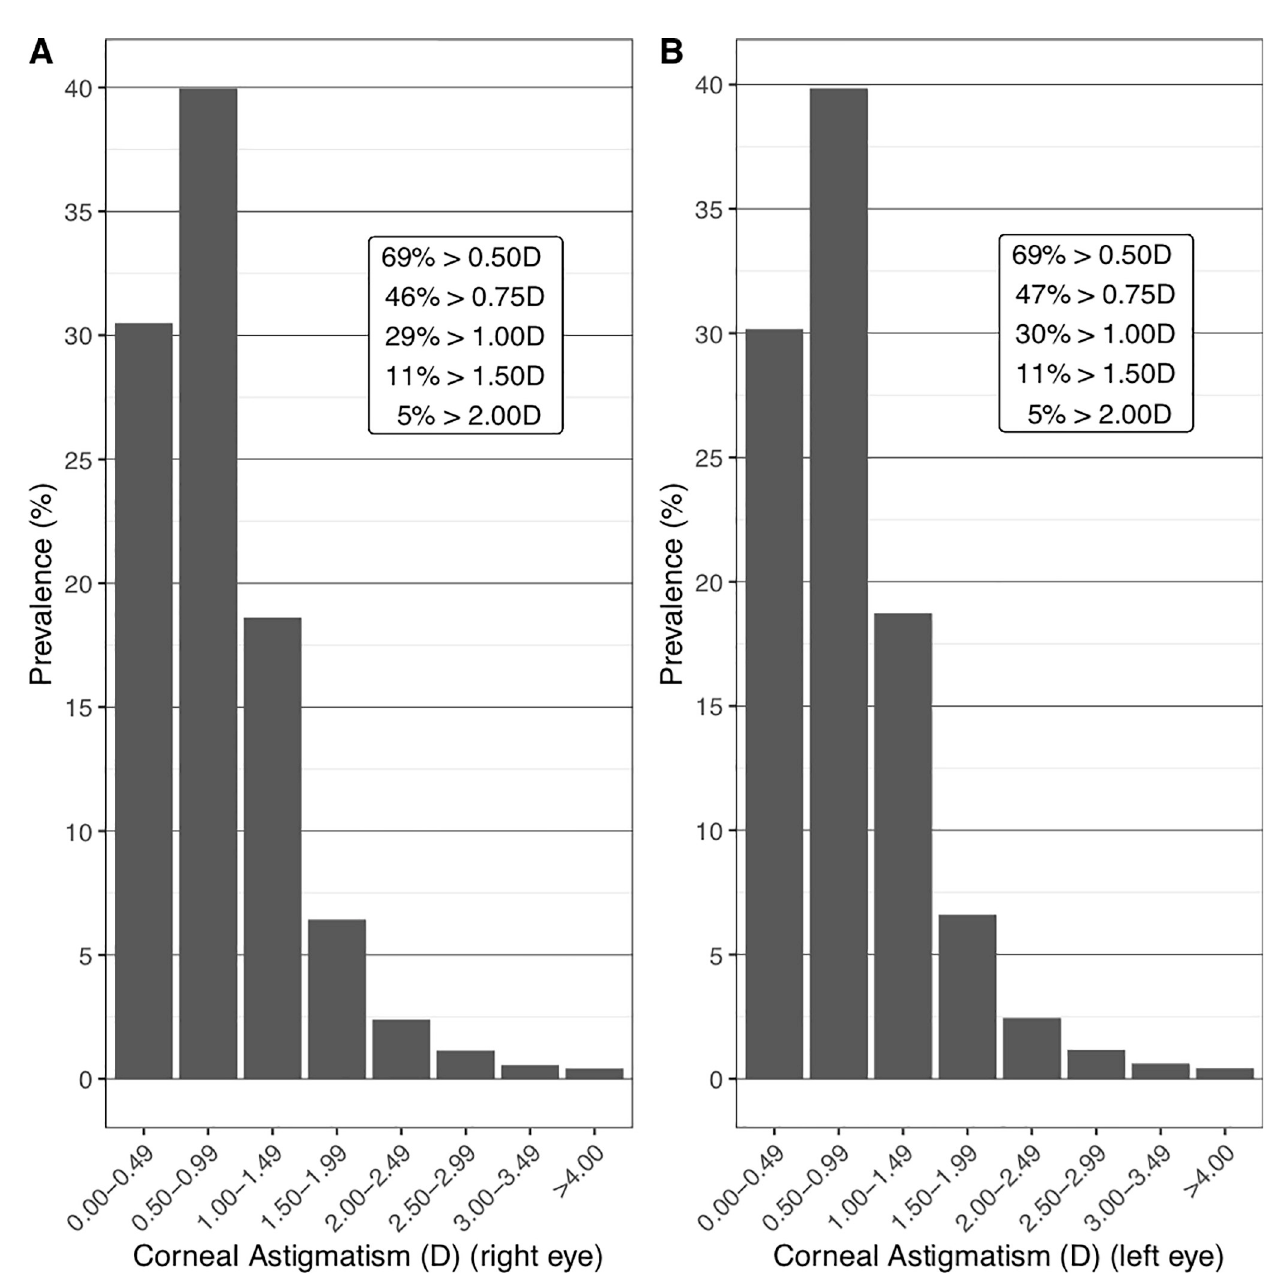
Fig 1. Distribution of corneal astigmatism in the UKBB in bins of 0.5D. (A) Distribution of corneal astigmatism in right eye. (B) Distribution of corneal astigmatism in left eye.